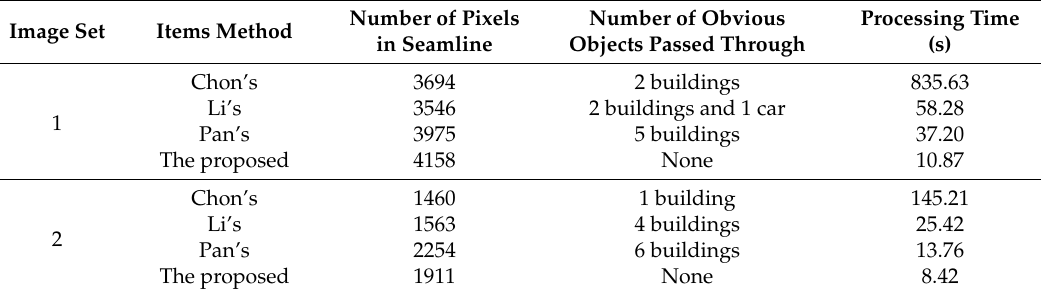
Table 1. Comparison of different methods